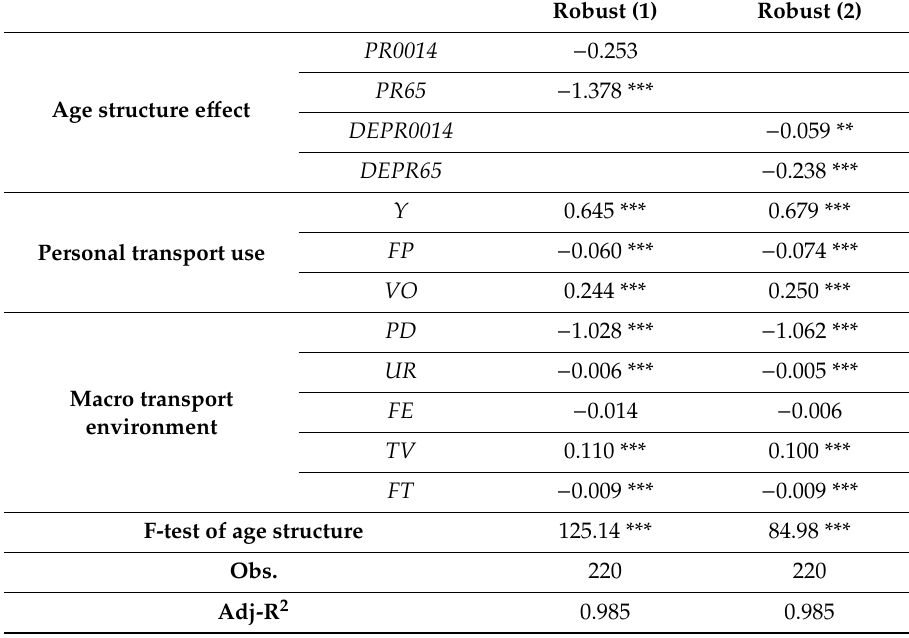
Table 4. Robustness estimation results: Robust (1) and Robust